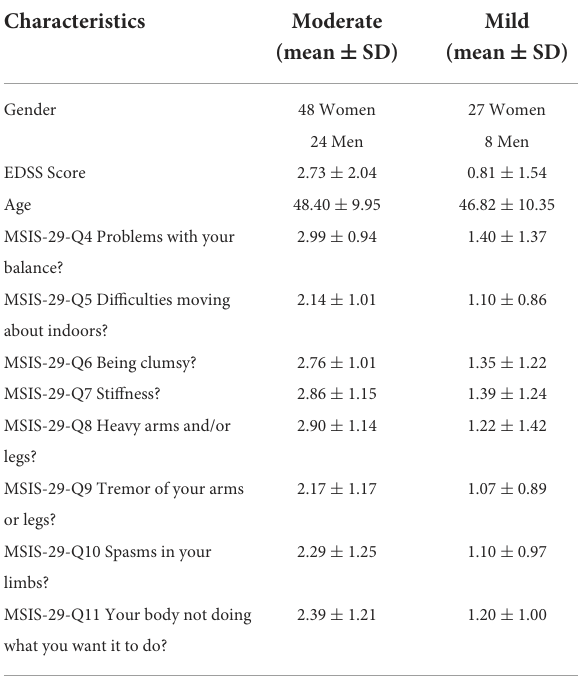
TABLE 1 Patient demographic data and MSIS-29